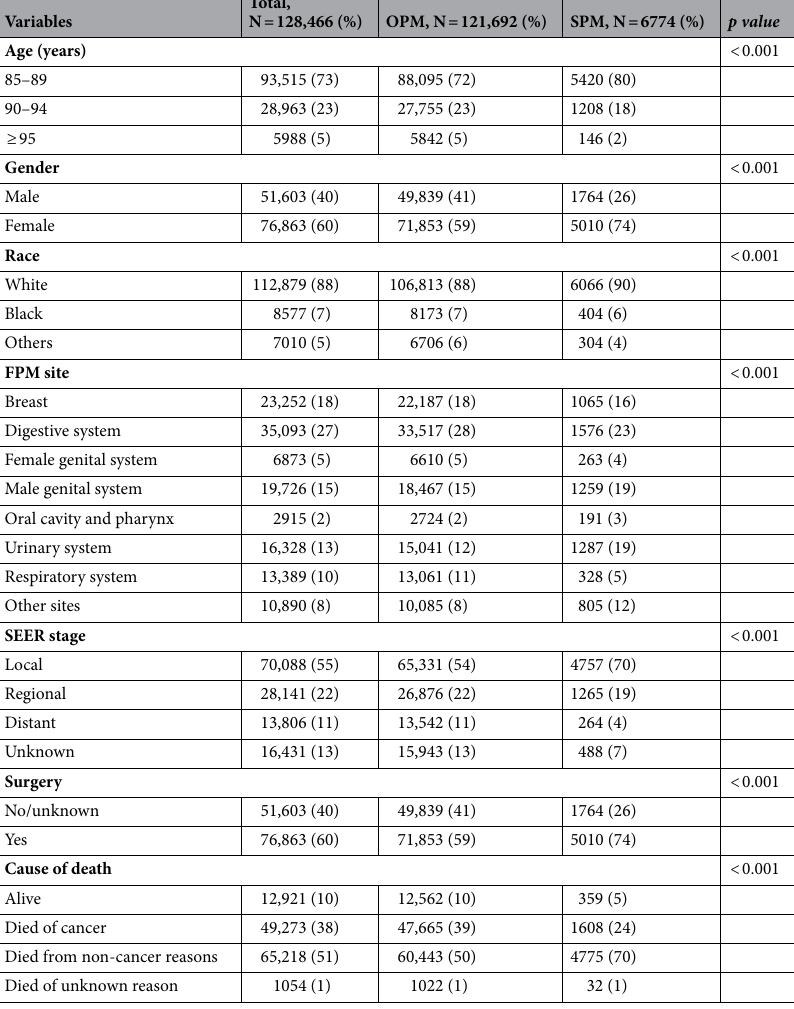
Table 1. Baseline clinical features comparison between OPM group and SPM group. OPM one primary malignancy; SPM second primary malignancy; FPM first primary malignancy; SEER surveillance, epidemiology, and end